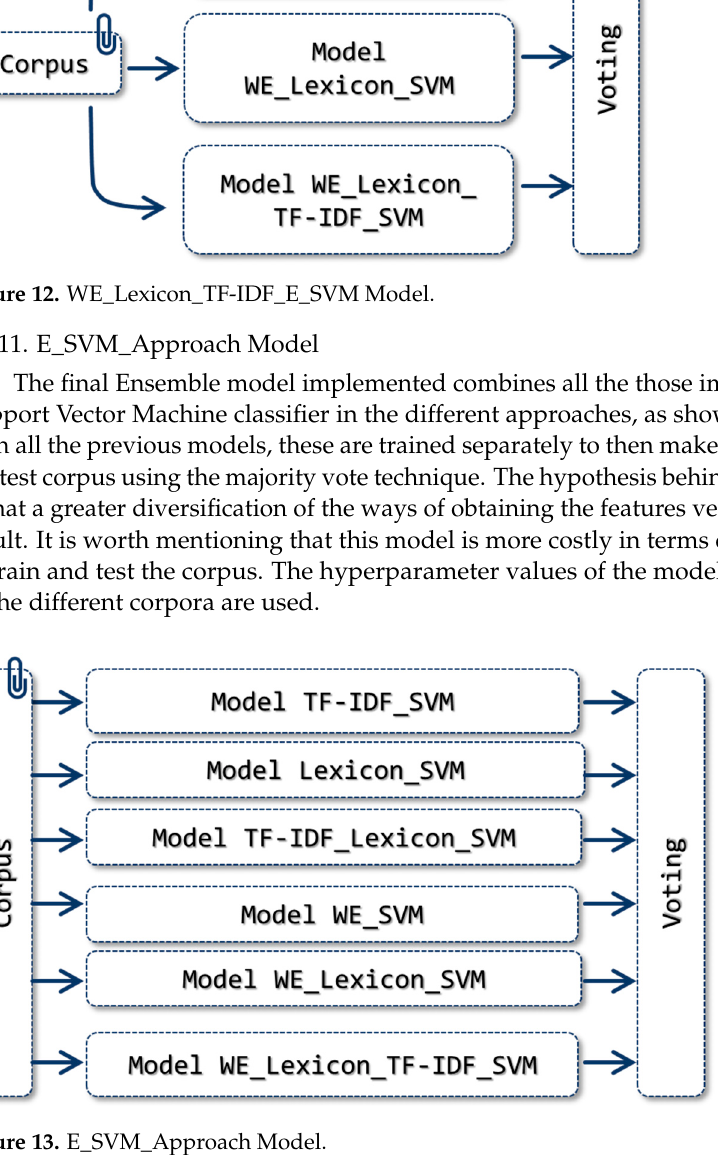
Figure 13. E_SVM_Approach Model.